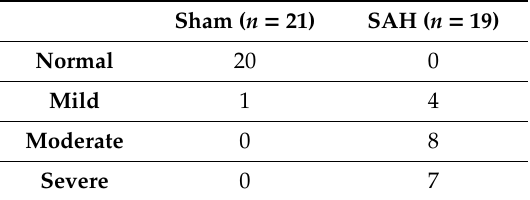
Table 1. Neurological deficits were evaluated using the Bederson Scale. Normal was judged as both forepaws reaching out (0); mild, as flexion of the contralateral limb (1); moderate, as decreased resistance to lateral push without circling (2); and severe, as decreased resistance to lateral push with circling (3). Sham ( n =